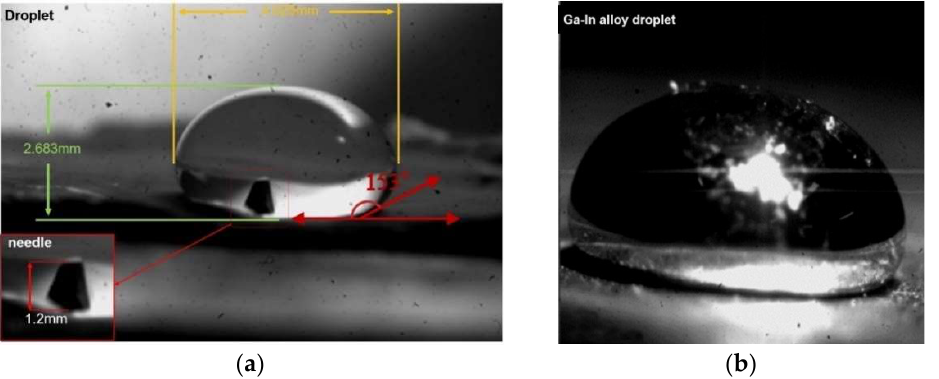
Figure 11. Experimental subject ( a ) Experimental water droplet and related parameters, ( b ) Experi-